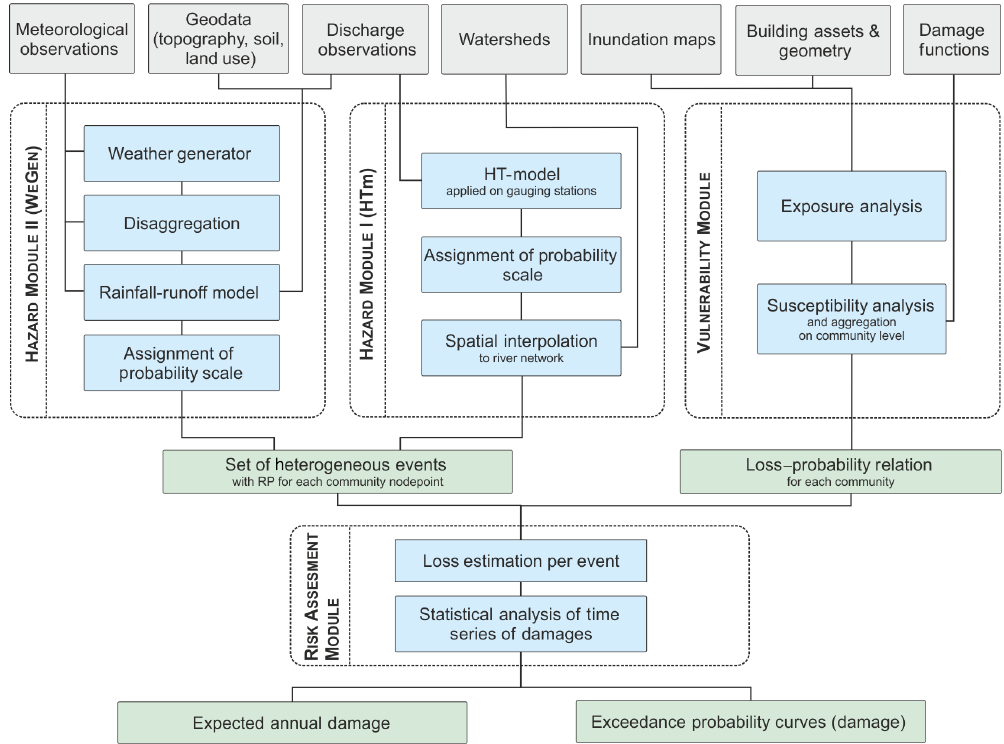
Figure 2. Flowchart of the PRAMo flood risk model including two different approaches for flood event